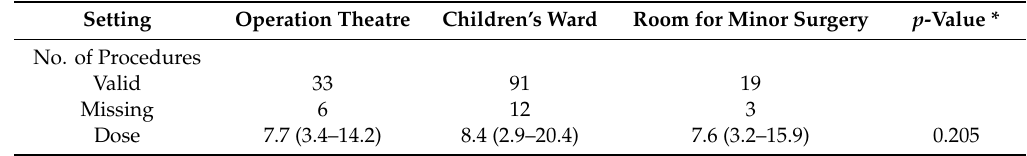
Table 3. Propofol dose (mg / kg), median